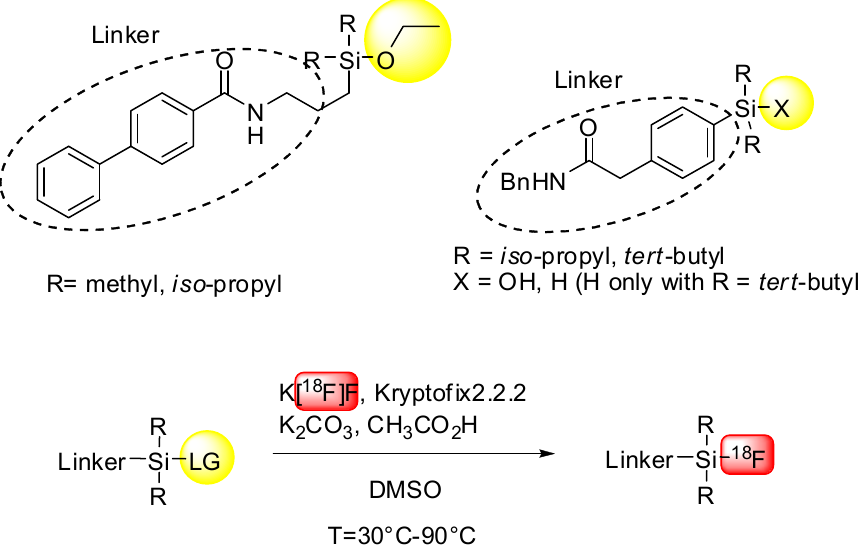
Figure 6 . Radioactive labeling of silicon building blocks bearing different leaving groups (LG = alkoxyl moiety, OH, H), sterically demanding residues (R = iso -propyl, tert -butyl) and linker structures